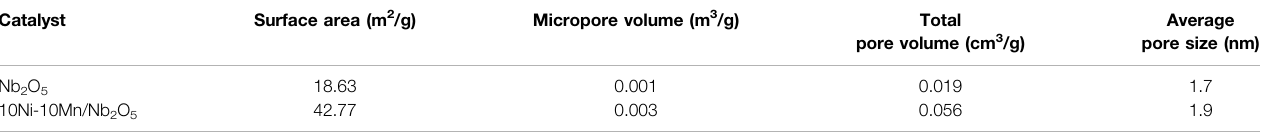
TABLE 1 | Physicochemical structure properties of Nb 2 O 5 and 10Ni-10Mn/Nb 2 O 5 catalysts.